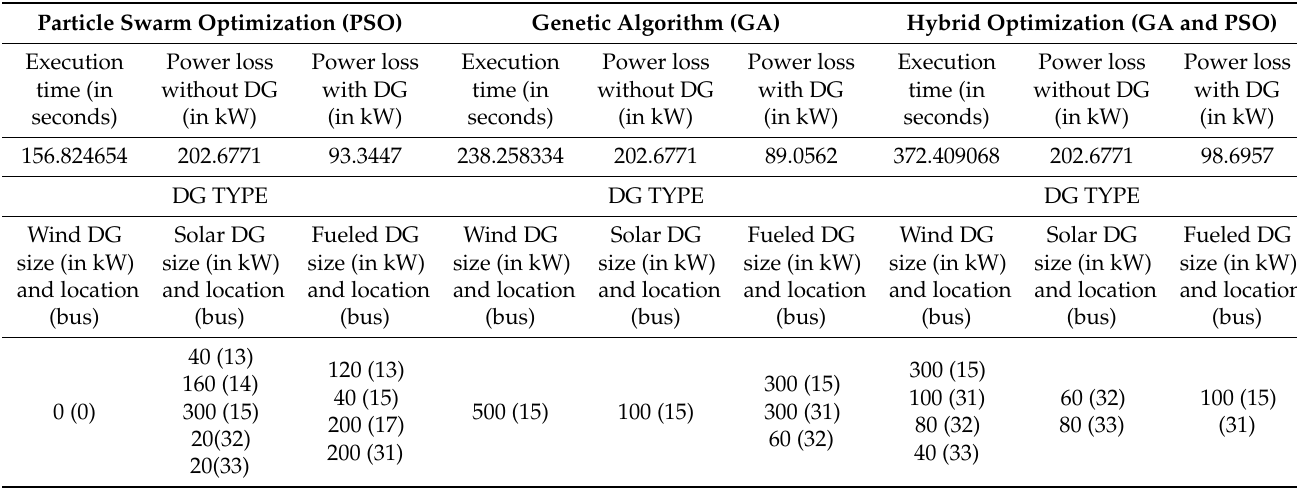
Table 5. Simulation results for optimal DGs size and their corresponding optimum location by PEM based method for scenario-1 using different metaheuristic optimization techniques. Particle Swarm Optimization (PSO) Genetic Algorithm (GA) Hybrid Optimization (GA and